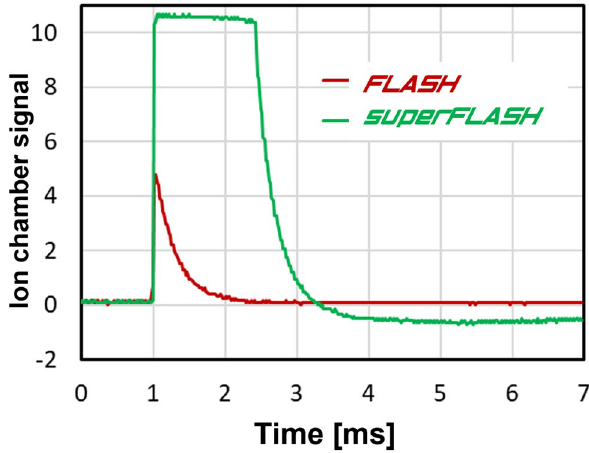
Figure 4. Signal from the built in ion chamber for the two operation modes.